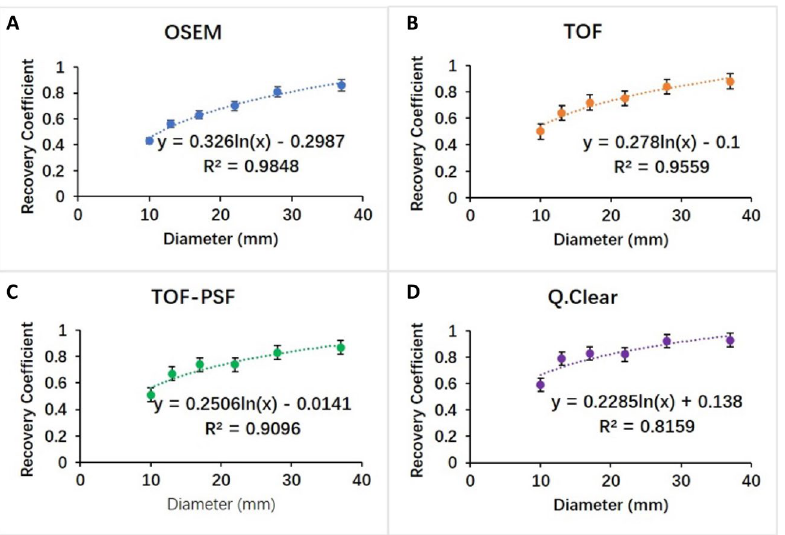
Figure 5. Recovery coefficients calculated based on PET images reconstructed with different algorithms ( A ) OSEM, ( B ) TOF, ( C ) TOF-PSF, ( D ) Q.Clear, showing as a function of measured sphere diameter on CT images. The equations and R2 values of linear fittings between recovery coefficient and measured sphere diameter were presented. Error bars shown are 1 SD.